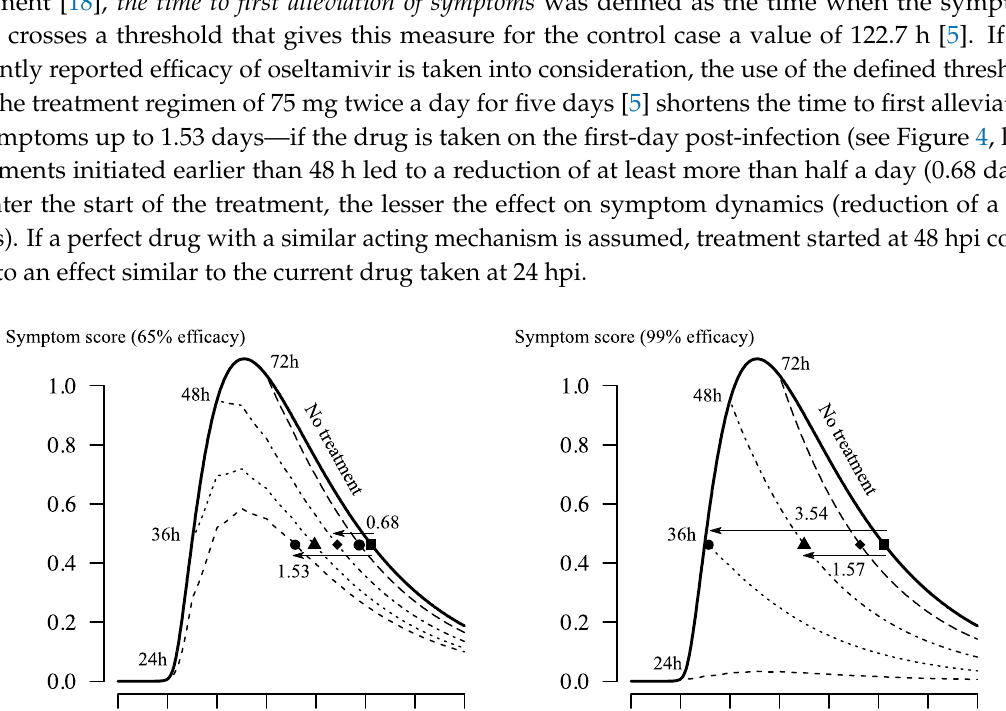
Figure 4. Illustration of the treatment effect on symptom score dynamics. Different shapes were used to indicate the time to first alleviation of symptoms of corresponding dynamics. The simulated treatment is 75 mg of oseltamivir taken twice daily, starting at different times post-infection; the solid line is the case without treatment. The value 122.7 h is the median of time to symptom alleviation